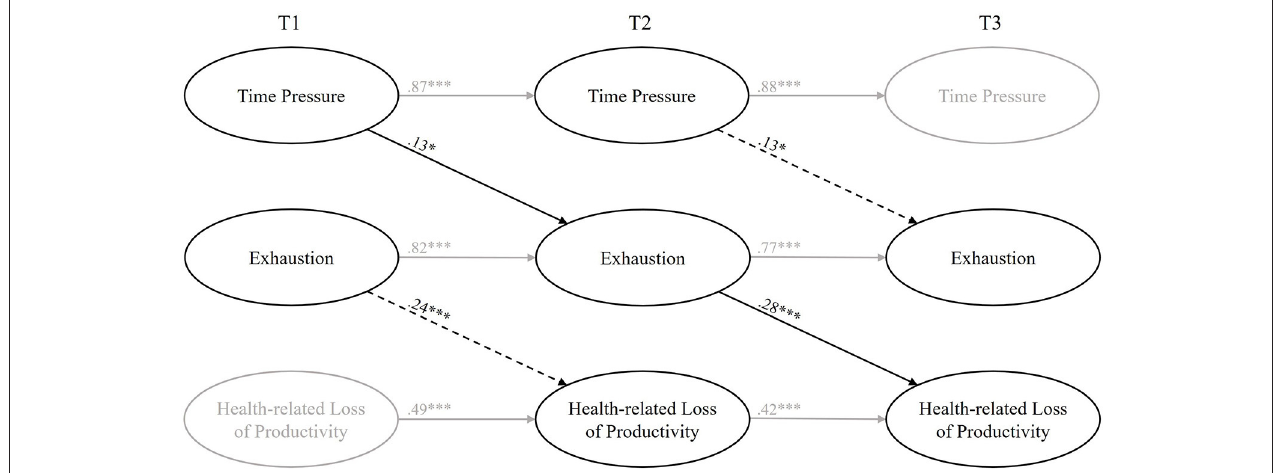
FIGURE 3 | The final model. The manifest variables are not shown in this figure. * p > 0.05; ** p > 0.01; *** p >